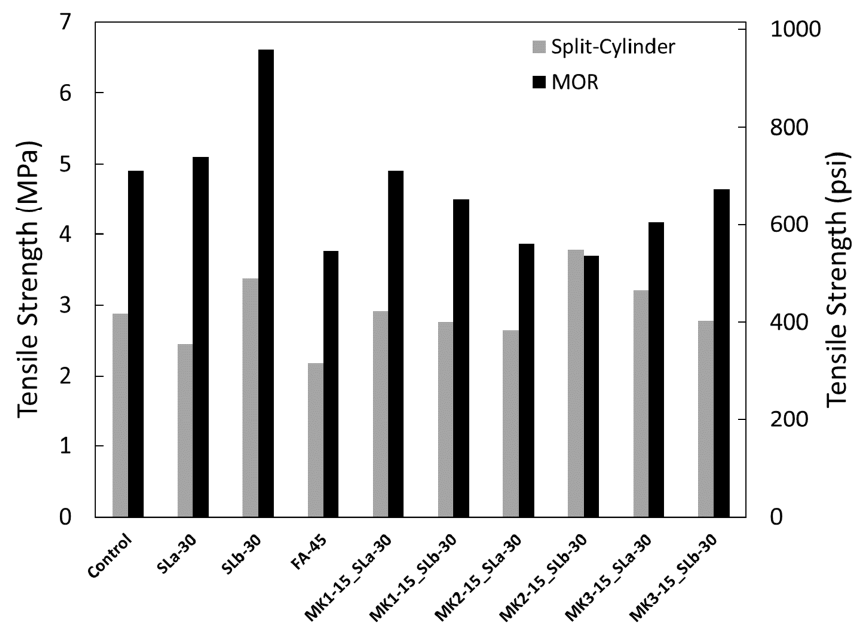
Figure 3. Tensile strength of non-metakaolin binary and ternary SCM mixtures.